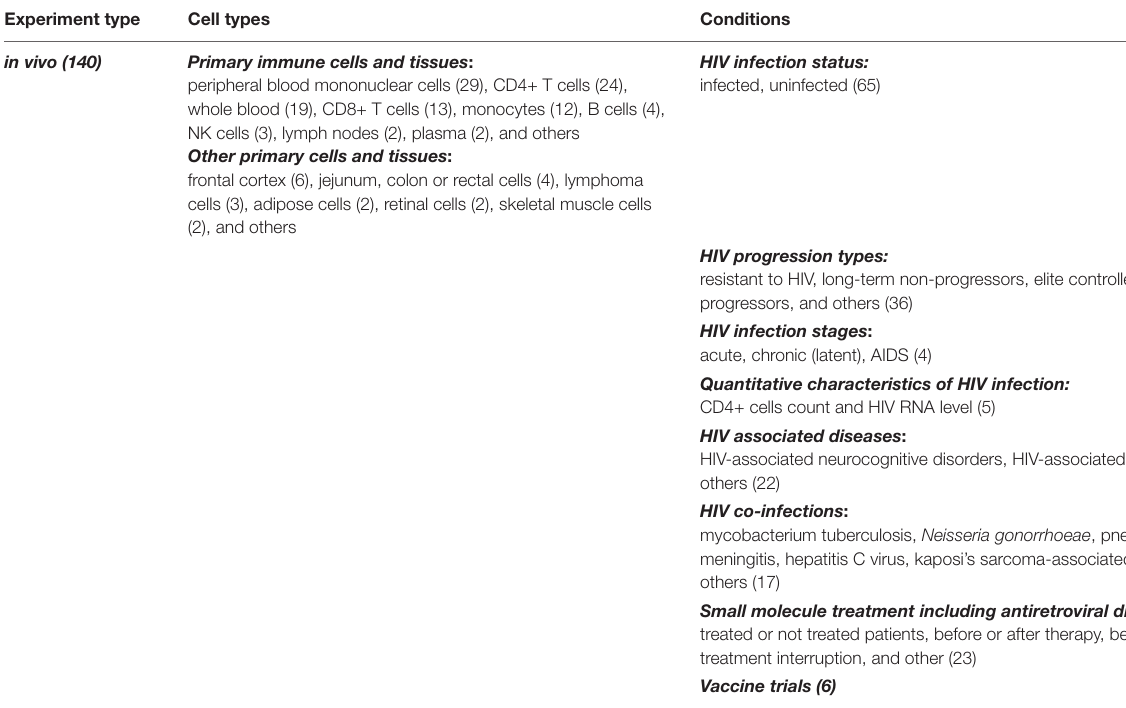
TABLE 4 | An overview of HIV-related transcriptomic experiments. Experiment